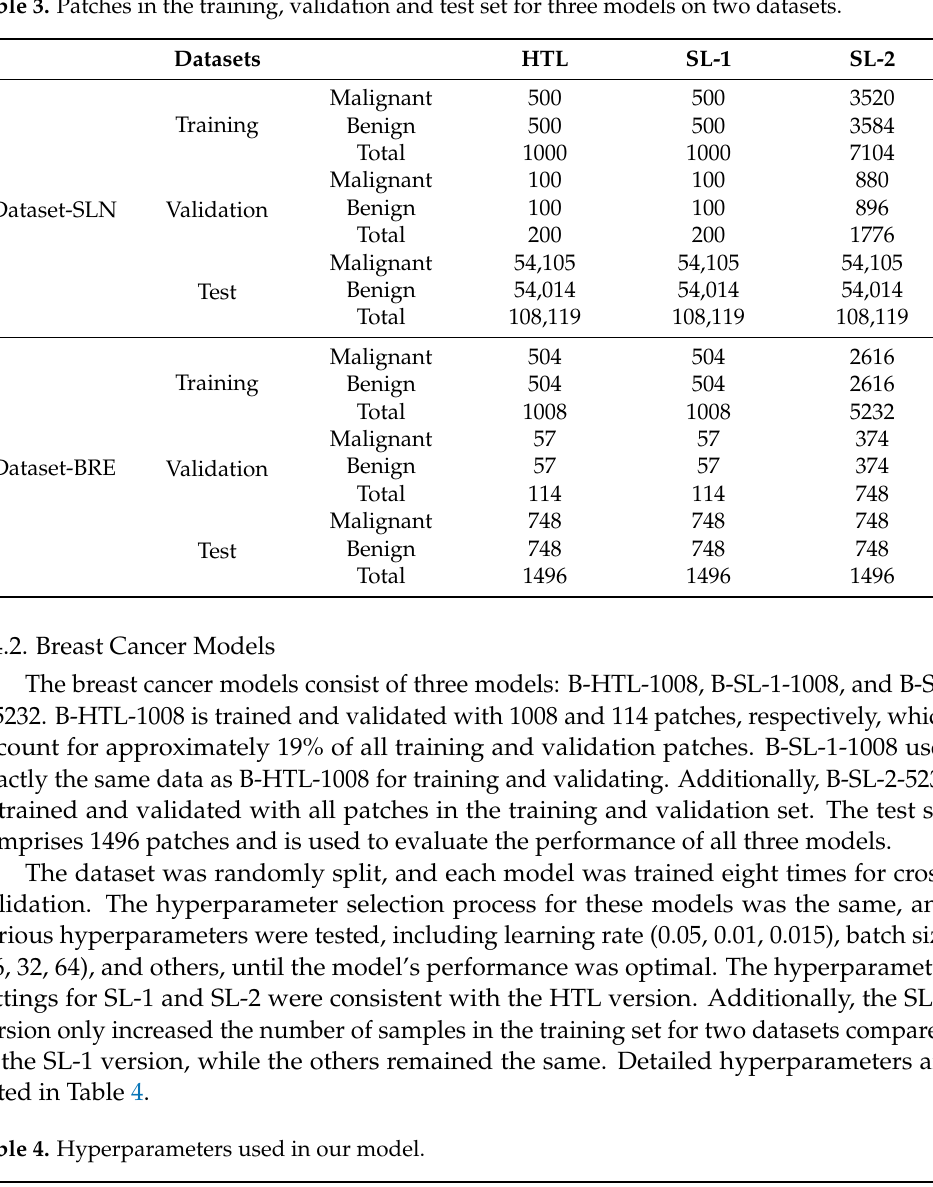
Table 3. Patches in the training, validation and test set for three models on two datasets.